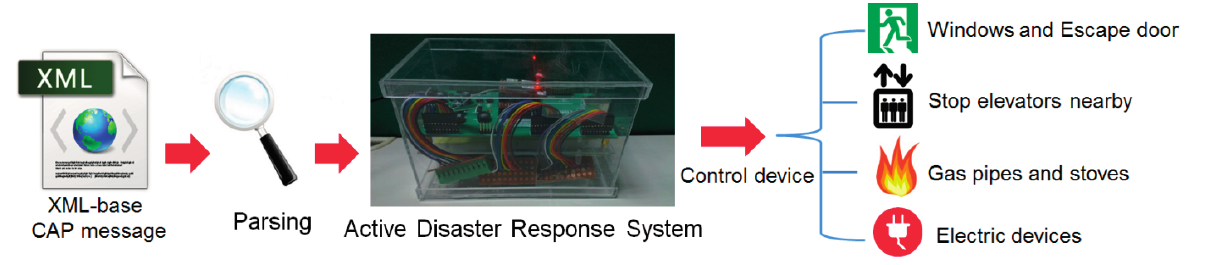
Figure 6. The flow of parsing CAP messages and controlling devices.